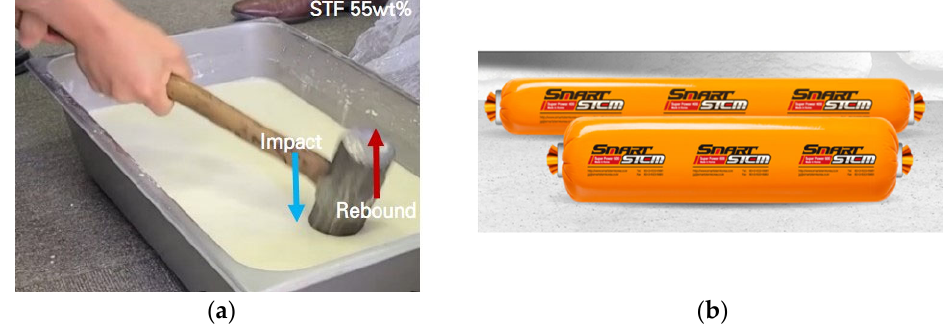
Figure 4. ( a ) Shear thickening fluid ‐ based stemming material image and ( b ) package products .